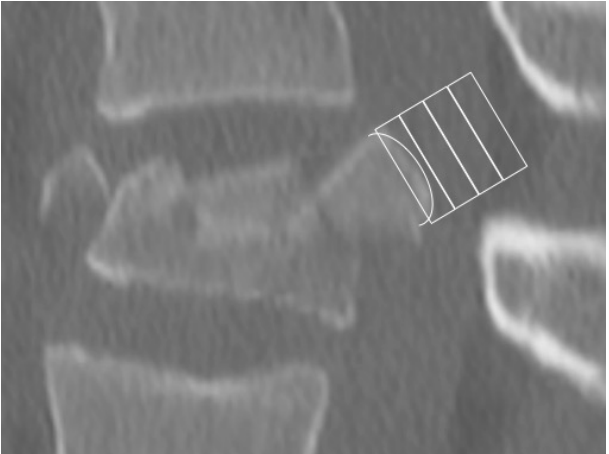
Figure 3. Sagittal picture of a displaced vertebral body fracture of a 17-year-old female patient after a fall from a horse. The analysis shows bulging into box 1.